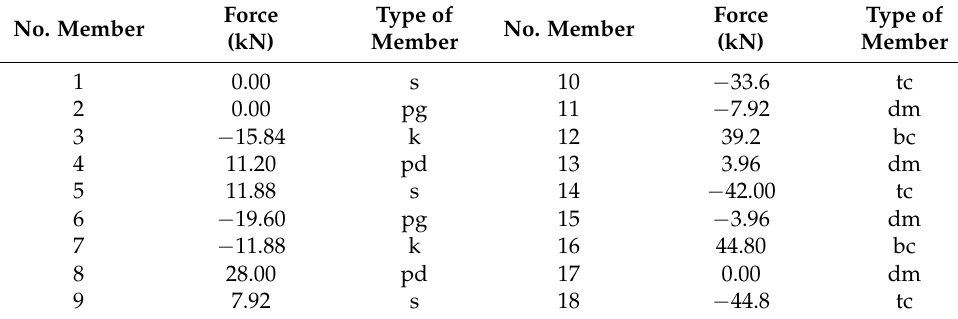
Table 1. Values of forces in bars—scheme A (Figure